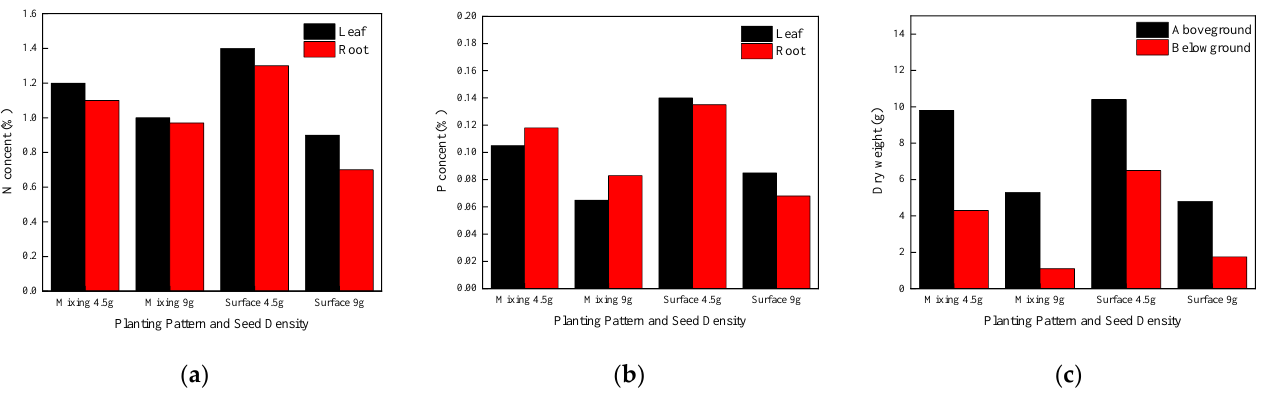
Figure 16. The elemental content and aboveground and belowground biomass of tall fescue. ( a ) Total nitrogen content. ( b ) Total phosphorus content. ( c ) Aboveground and belowground Biomass.